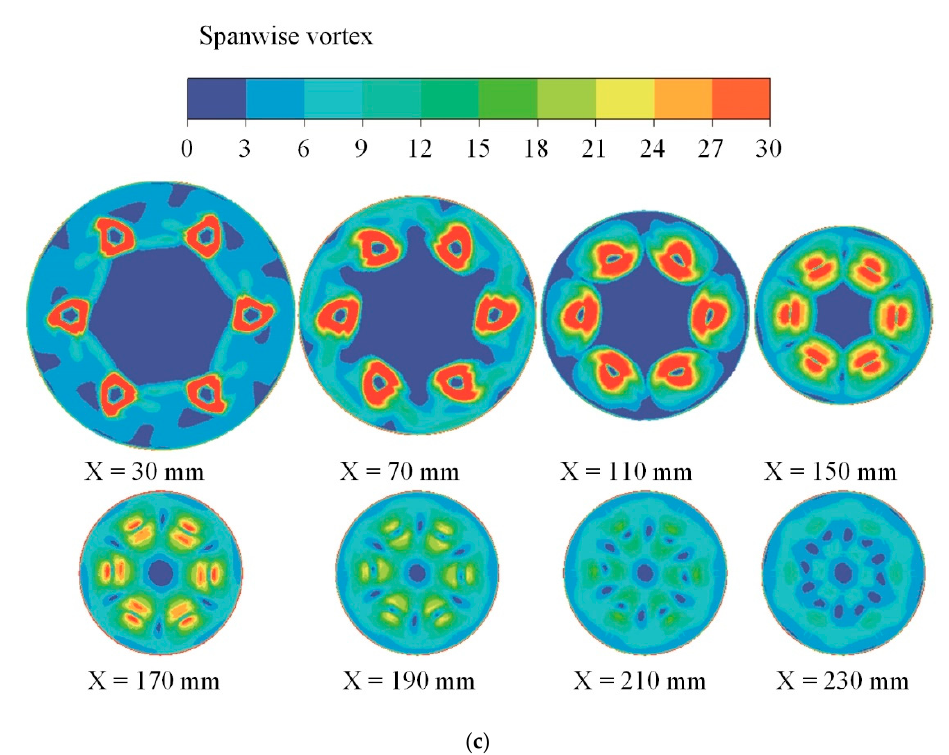
Figure 10. Spanwise vortex distribution. ( a ) Square nozzle; ( b ) Circular nozzle; ( c ) Triangle nozzle. The maximum spanwise vorticity values along the axial direction x from the suction chamber to the throat are plotted in Figure 11. It can be seen that the maximum spanwise vorticity value decays rapidly in the suction chamber similar to the streamwise vortex. Then after the mixing of the two fluids in the downstream throat to a certain extent, this value still fluctuates with obvious ups and downs. During the process, the maximum spanwise vorticity peak value of the square nozzle is 19% less than that of the circular nozzle and 12% less than that of the triangular nozzle.